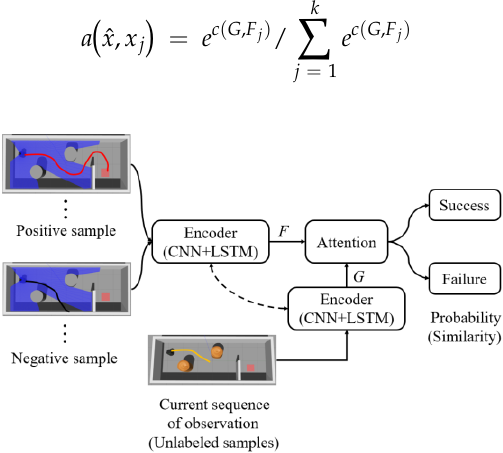
Figure 2. Matching network reward in mapless navigation.